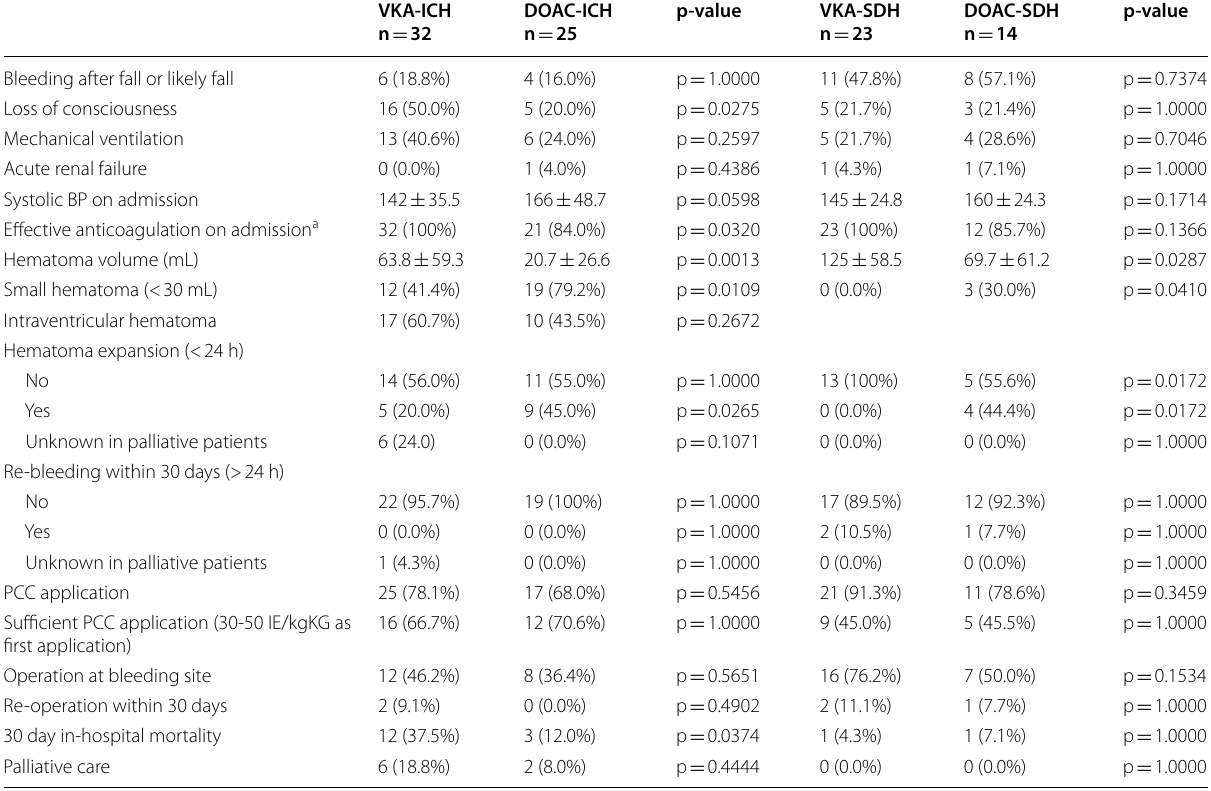
Data are presented as n (%) or mean